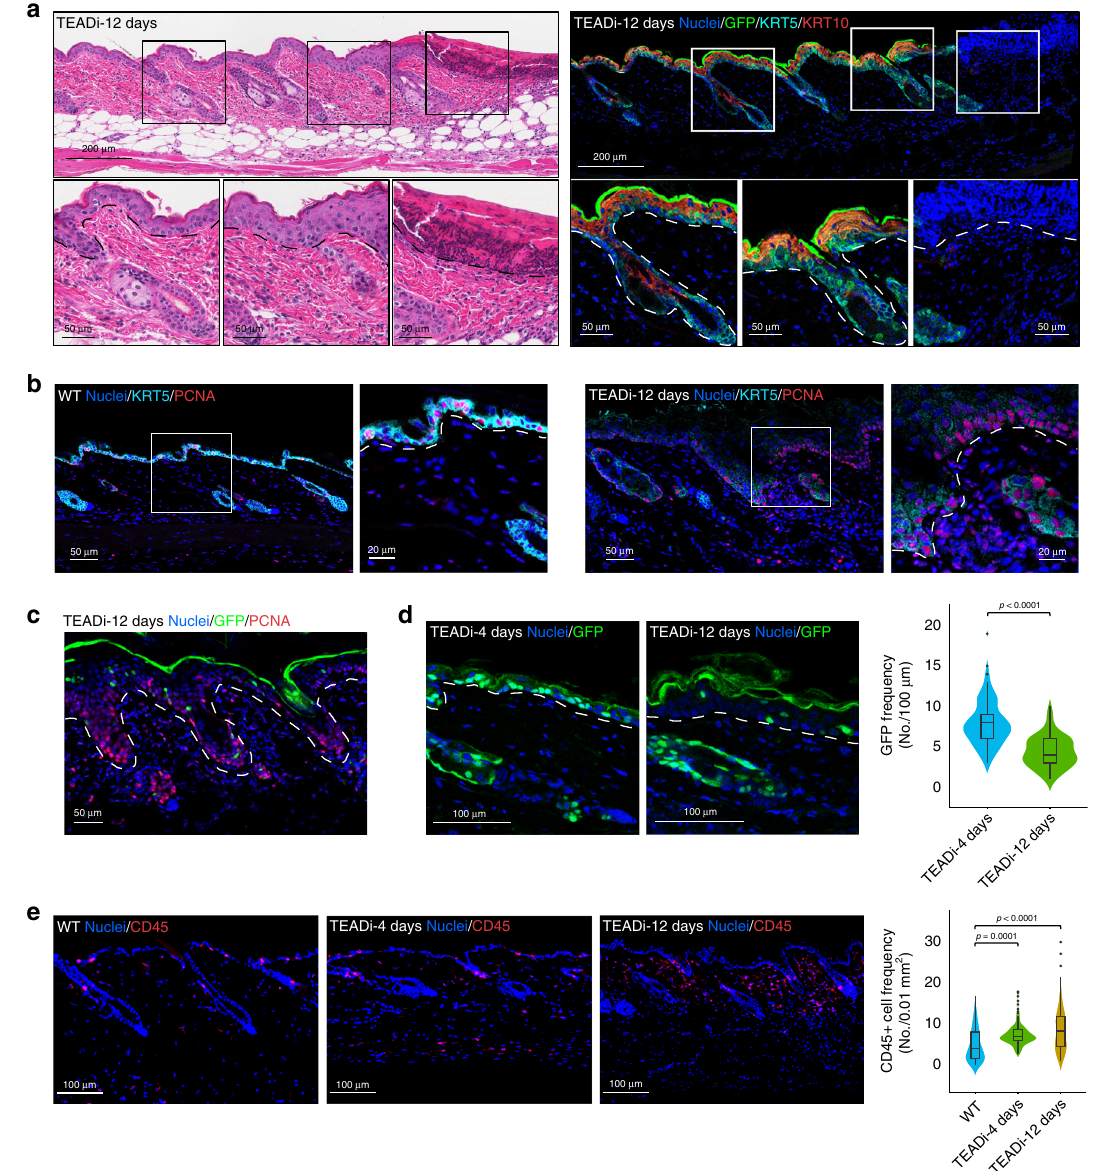
Fig. 6 TEADi expression in the mouse skin induces wounding and in fl ammation. a Histology and IF pictures of the skin of a TEADi-expressing mouse showing a wound area and the surrounding epithelium. b Representative IF pictures of the skin of WT or TEADi mice induced for 12 days to show expression of the proliferation marker PCNA and the basal marker KRT5. c Representative IF picture of the skin of TEADi mice induced for 12 days to show expression of the proliferation marker PCNA and GFP. d Representative IF pictures and quanti fi cation of the skin of TEADi mice induced for 4 and 12 days to show expression of GFP. e Representative IF pictures and quanti fi cation of immune cell in fi ltration labeled by CD45 staining in the skin of TEADi mice. Inserts show magni fi cation of the highlighted area. Location of the basal membrane is indicated with a white dotted line. In d 4d n = 69 and 12d n = 61; ( e ) WT n = 107, 4d n = 106 and 12d n = 114 fi elds from 3 different mice in each condition. Violin plots shows density of data and box plot shows median, 25 and 75% quartile, 95% con fi dence interval and dots indicating potential outliers; in d two-tailed unpaired t test and in e two-way ANOVA with Dunnett ’ s multiple comparison test. Source data are provided as a Source Data fi